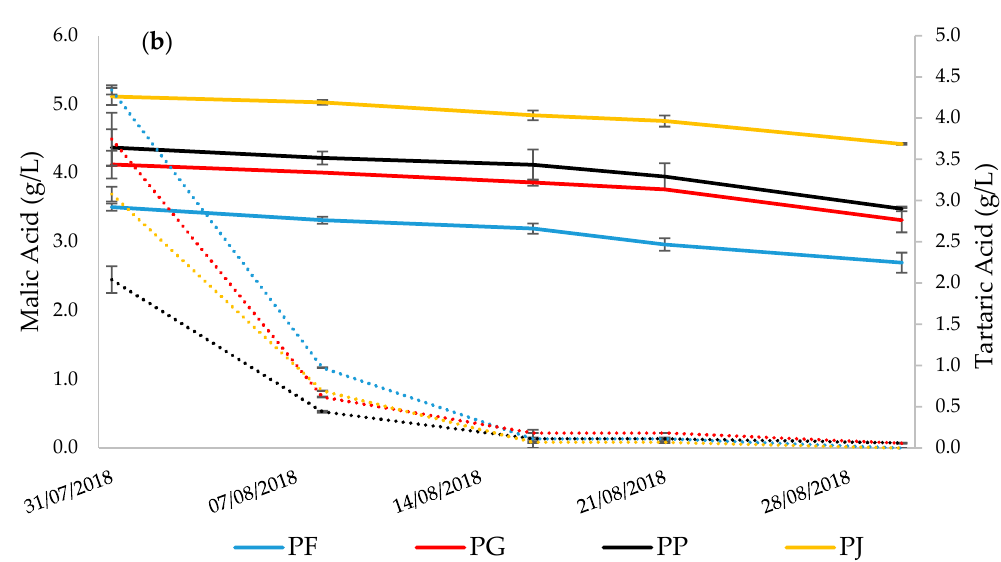
Figure 2. ( a , b ) Evolution of total acidity (left axis, dotted line) and sugar concentration (right axis, solid line) ( a ) and malic (left axis, dotted line) and tartaric acid (right axis, solid line) ( b ) during ripening final stages of Palomino Fino (PF), Palomino Gacho (PG), Palomino Pelusón (PP) and Palomino de Jerez (PJ).